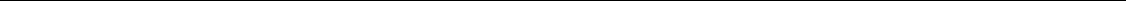
Fig. 5 Overexpression of C/EBP β in young 3xTg mice accelerates the onset of AD-like pathogenesis and worsens cognitive dysfunctions. a Overexpression of C/EBP β escalates delta-secretase and APP and Tau cleavage. Hippocampal tissues were analyzed by immunoblotting. C/EBP β -induced active delta- secretase was antagonized by the co-expression of C189S mutant ( n = 3 mice per group). b , c Overexpression of C/EBP β but not C/EBP α increases delta- secretase mRNA and enzymatic activities. Data represent mean ± s.e.m. of three mice per group (* P < 0.05, ** P < 0.01, one-way ANOVA). d Overexpression of C/EBP β but not C/EBP α increases the expression of in fl ammatory cytokines. Data represent mean ± s.e.m. of three mice per group (* P < 0.05, one-way ANOVA). e C/EBP β overexpression enhances the early formation of amyloid plaques in 3xTg mice. Thio fl avin S staining for the senile plaques (top, scale bar, 50 μ m). Analysis data (middle) represent mean ± s.e.m. of 12 – 18 sections from three mice per group and A β ELISA (lower) represent mean ± s.e.m. of three mice per group (* P < 0.05, ** P < 0.01, one-way ANOVA). f Overexpression of C/EBP β decreases dendritic spine density. Golgi staining was conducted on brain sections from apical dendritic layer of the CA1 region. Scale bar, 5 μ m. Data (right) represent mean ± s.e.m. of 9 – 12 sections from three mice in each group. (* P < 0.05, one-way ANOVA). g Electrophysiology analysis. C/EBP β overexpression worsened the LTP defects in 3xTg mice. The ratio of paired pulses (mean ± s.e.m.; n = 6 in each group; * P < 0.05 compared with 3xTg-Ct, # P < 0.05 compared with 3xTg-C/ EBP β + AEP C189S, one-way ANOVA) (left). LTP of fEPSPs (mean ± s.e.m.; n = 6 in each group; *P < 0.05 compared with 3xTg-Ct, # P < 0.05 compared